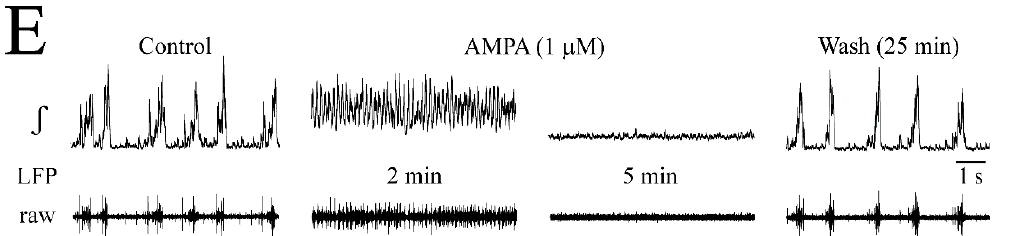
Figure 1. Local field potential (LFP) pattern transformation by the ionotropic glutamate receptor (iGluR) agonist α -amino-3-hydroxy-5-methyl-4-isoxazole propionic acid (AMPA). Bottom traces